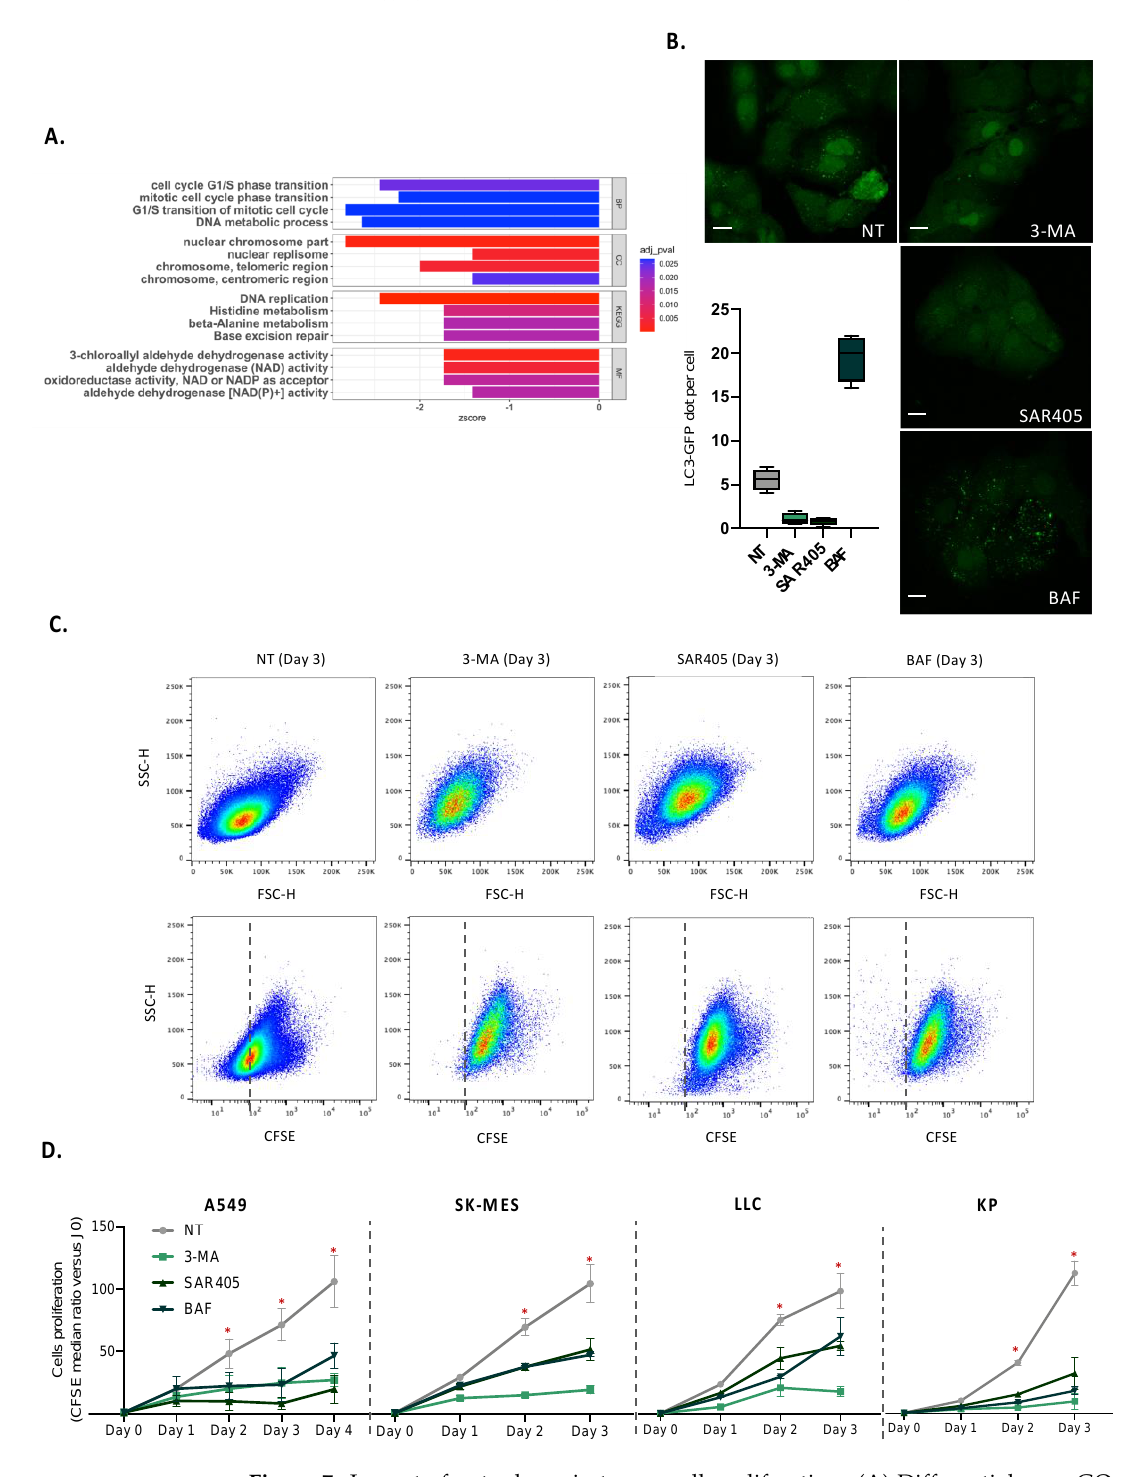
Figure 7. Impact of autophagy in tumor cell proliferation. ( A ) Differential gene GO and KEGG enrichment analysis in GSE73158 datasets (A549 control versus autophagy deficient), BP stands